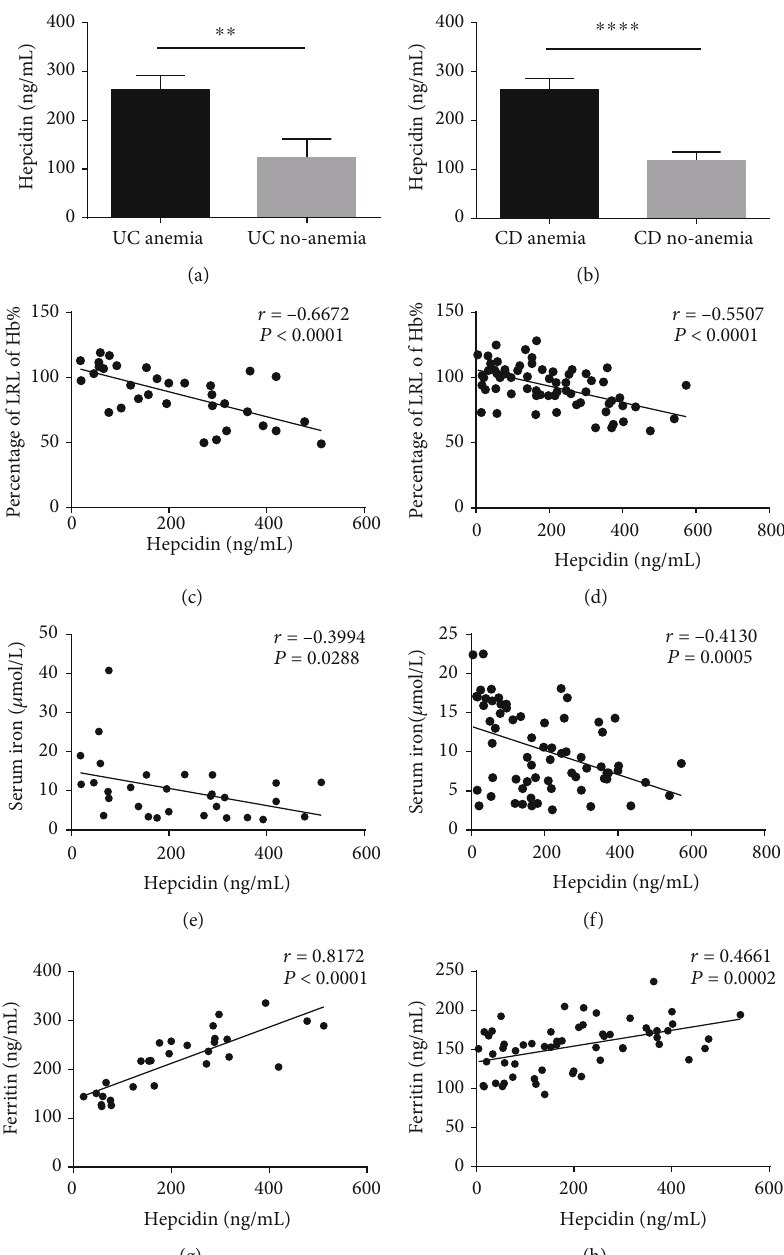
Figure 2: The serum levels of hepcidin are correlated with the severity of anemia in IBD patients. (a) The serum levels of hepcidin in UC patients with anemia ( n = 21 ) and UC patients without anemia ( n = 12 ). (b) The serum levels of hepcidin in CD patients with anemia ( n = 36 ) and CD patients without anemia ( n = 28 ). ∗∗∗∗ P < 0 : 0001 , ∗∗∗ P < 0 : 001 , and ∗∗ P < 0 : 01 . Data were expressed as mean ± SEM , unpaired Student ’ s t -tests. (c) Correlation between hepcidin and percents of LRL of Hb in UC patients ( n = 33 ). (d) Correlation between hepcidin and percentages of LRL of Hb in CD patients ( n = 66 ). (e) Correlation between hepcidin and serum iron in UC patients ( n = 30 ). (f) Correlation between hepcidin and serum iron in CD patients ( n = 66 ). (g) Correlation between hepcidin and serum ferritin in UC patients ( n = 33 ). (h) Correlation between hepcidin and serum ferritin in CD patients ( n = 60 ). Correlation analysis was performed by Spearman ’ s correlation analysis. P values are shown in each